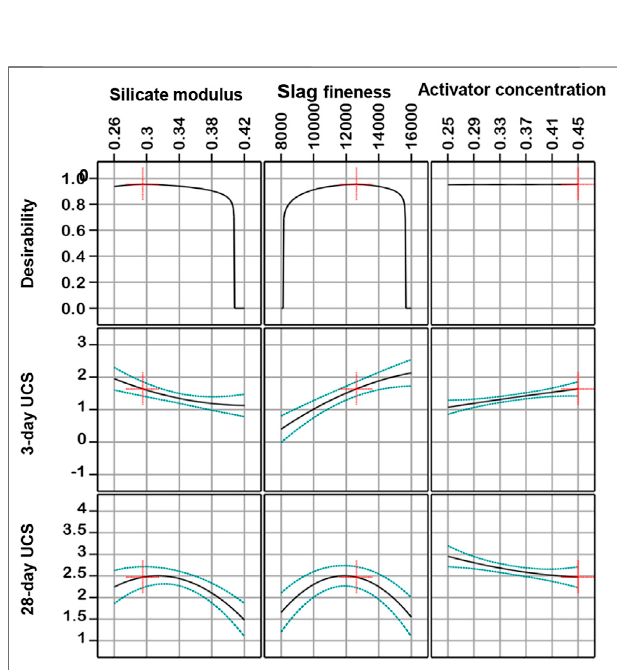
FIGURE 12 | Optimization results of